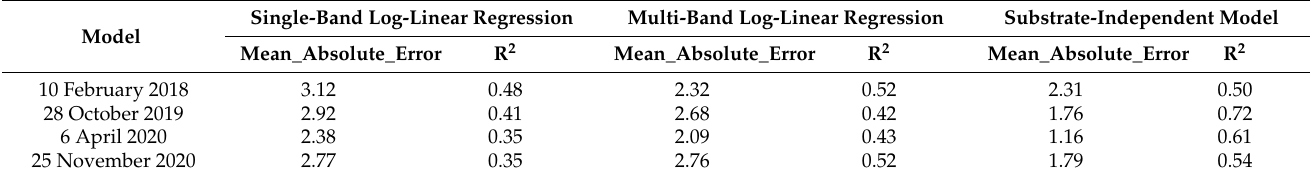
Table 10. Comparison of different performance metrics of inversion bathymetry results by different models. Units: